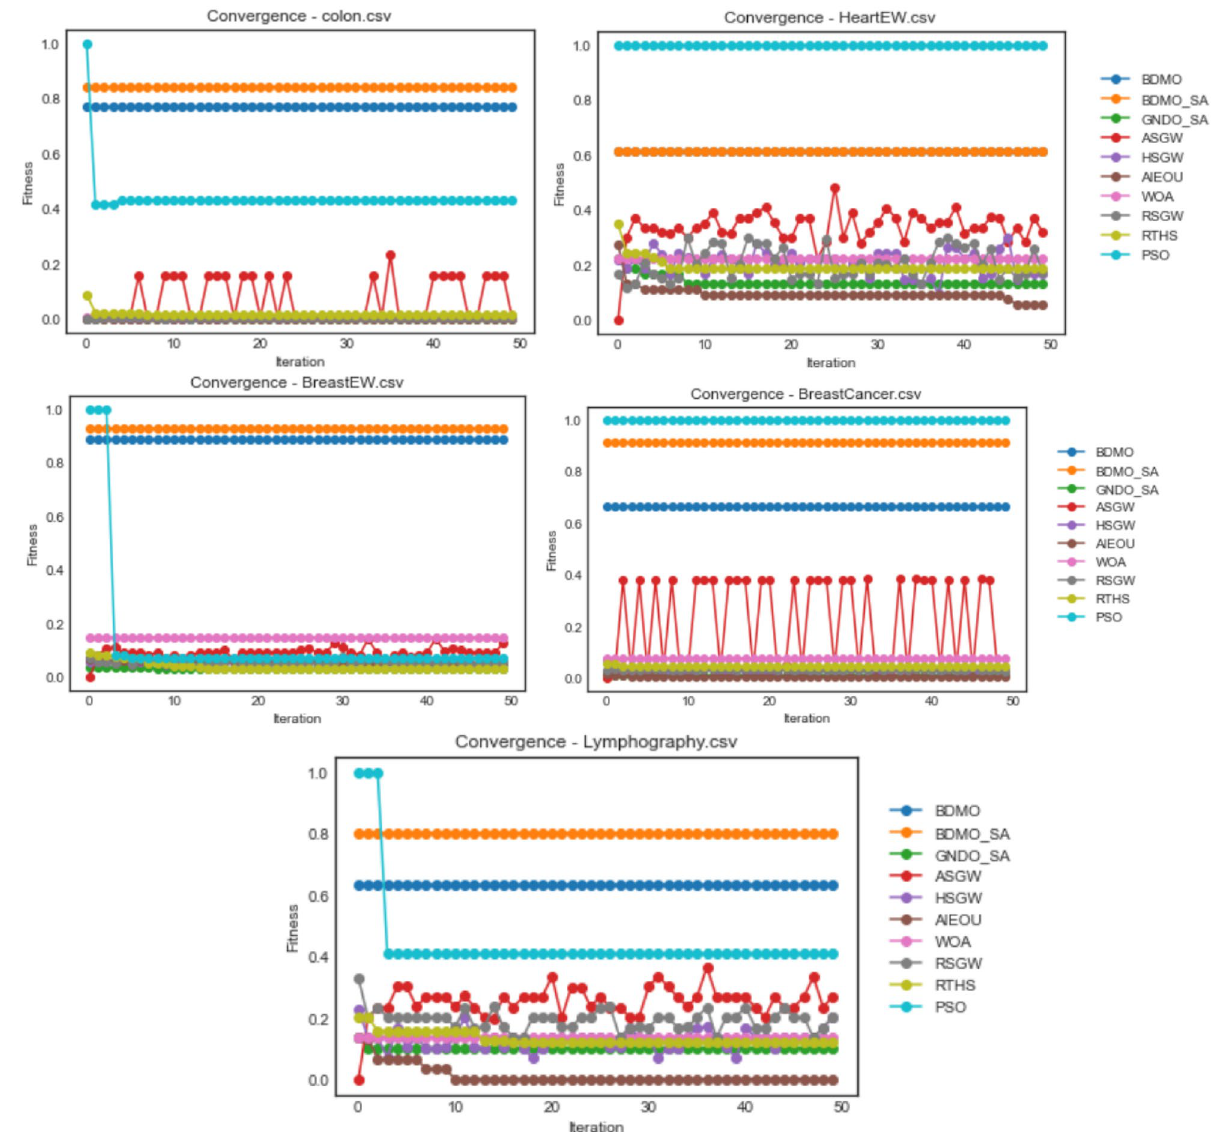
Figure 3. Convergence behavior of all algorithms on colon, HeartEW, BreastEW, BreastCancer, and Lymphography